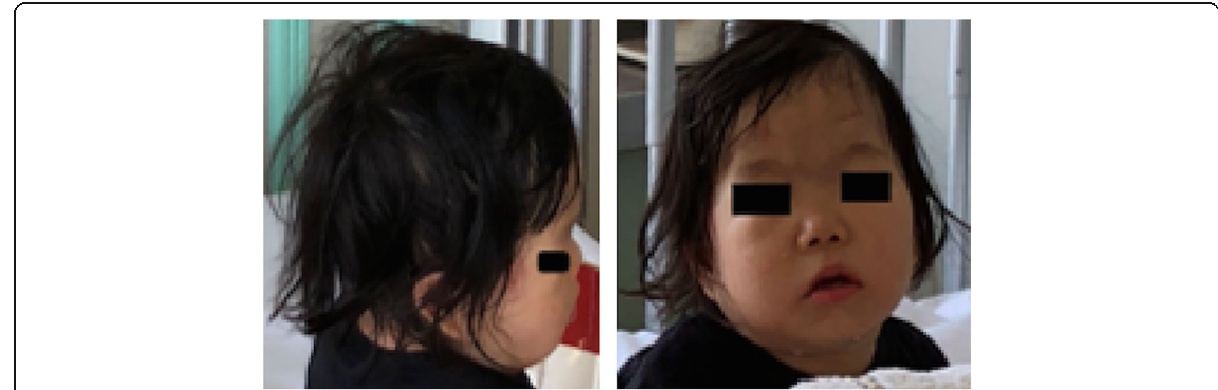
Fig. 1 Appearance of the head and neck. Pictures were taken during this